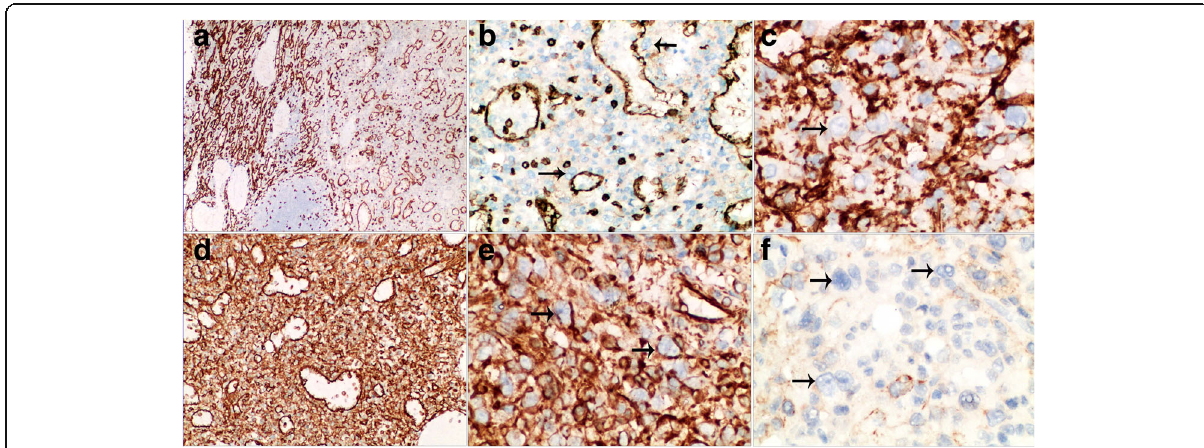
Fig. 3 a-b Immunostaining for CD8.The sinusoid-like structures are highlighted by CD8 in the splenic hamartoma, in addition to some small lymphocytes (a, ×40; b, ×200). Normal red pulp is shown for comparison (left field) (a, ×40). c Immunostaining for CD31 highlights the lining cells of disorganized sinusoid-like channels and histiocytes (c, ×400). d - e Immunostaining of vimentin is diffusely positive in the lesion (d, ×200; e, ×400). f Immunostaining of SMA is negative (×400). For all markers, the bizarre stromal cells (arrows, b, c, f) are negative, except for vimentin (arrows, e)